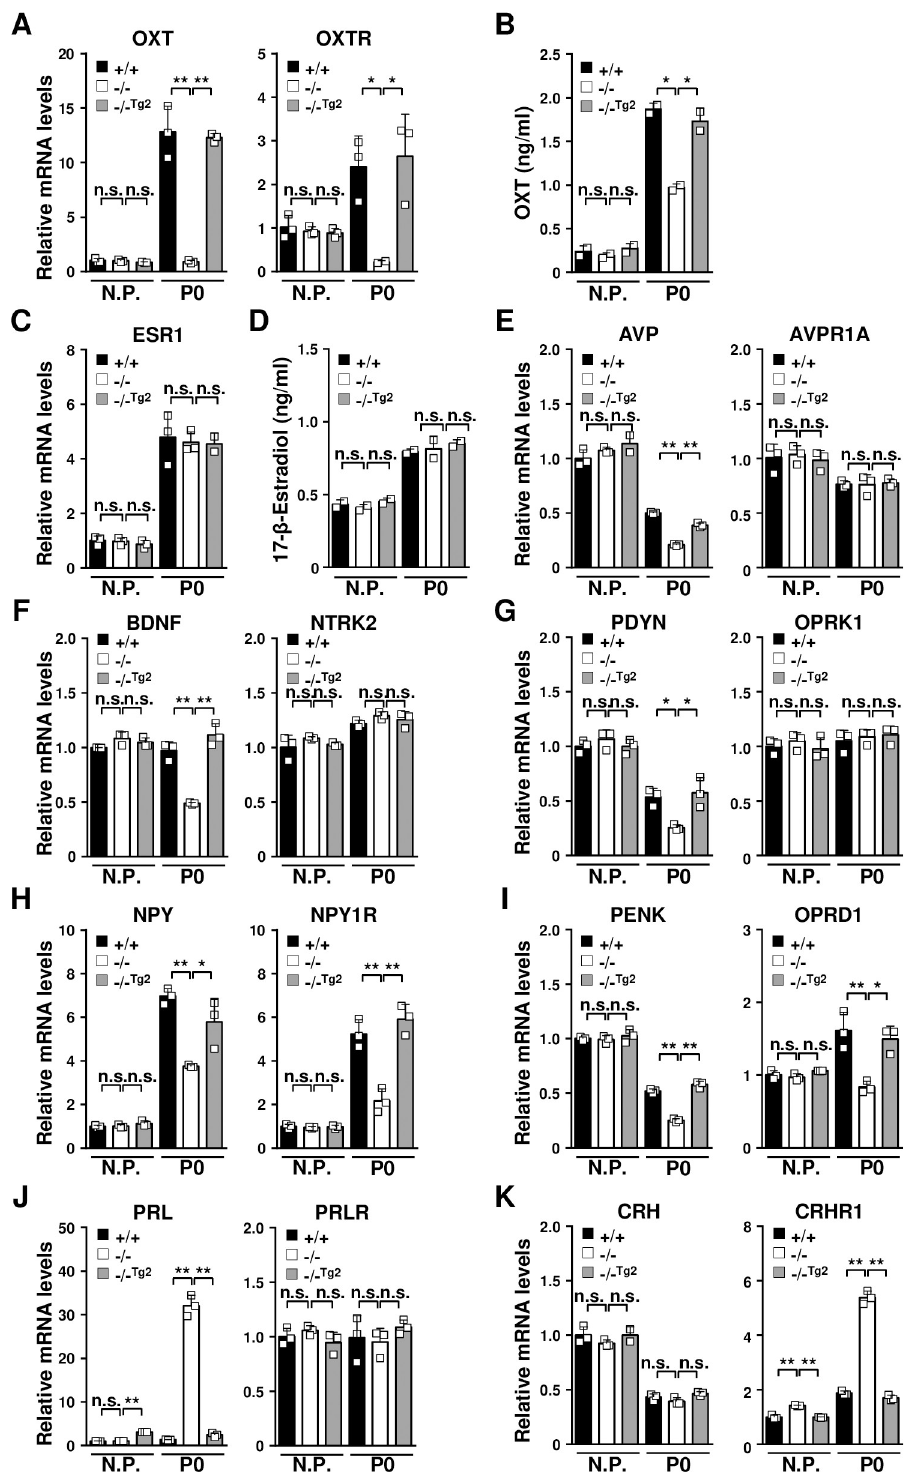
Fig 5. Dysregulation of neuroendocrine factors in the brain tissue of TDAG51 -/- dams after parturition. (A) Impaired expression of OXT and its receptor OXTR in TDAG51 -/- dams after parturition. Total RNA isolated from brain tissues was analyzed by real-time PCR using specific primers. N.P., nonpregnant mice. Black bar (+/+), TDAG51 +/+ dams. White bar (-/-), TDAG51 -/- dams. Gray bar (-/- Tg2 ), TDAG51 -/-Tg2 dams. (B) Serum OXT levels in